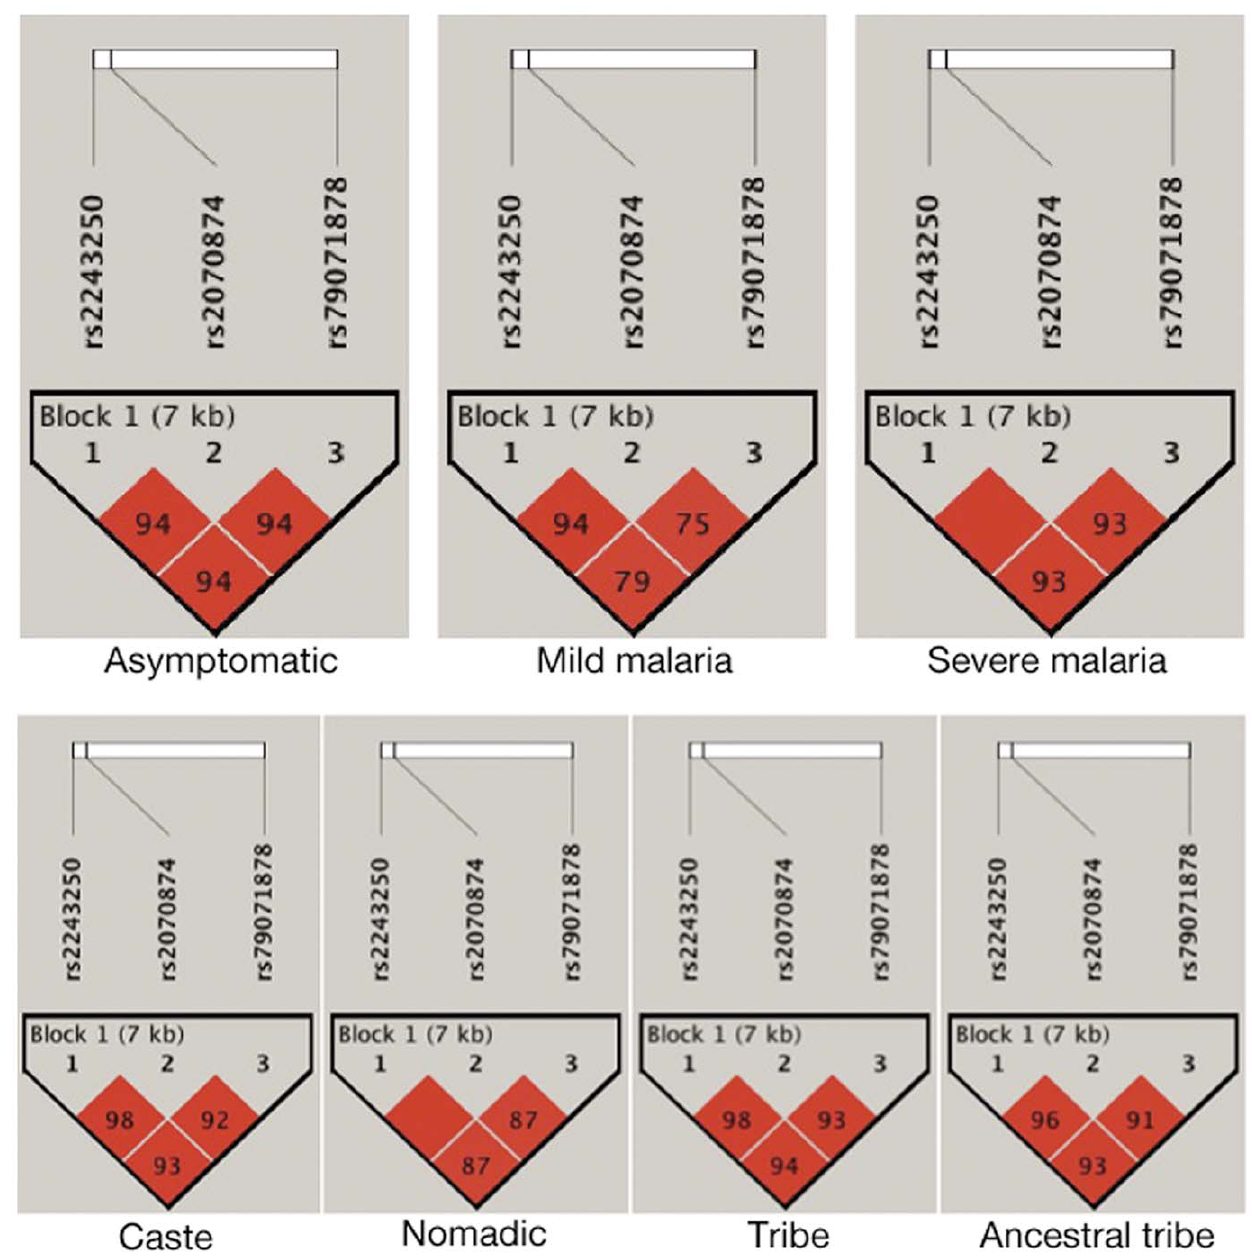
Figure 2. Linkage Disequilibrium (LD) of studied IL-4 loci (-590 C/T, -34 C/T and intron-3 VNTR) in malaria case control and Indian population groups. The three studied SNPs are in strong LD (r 2 . 0.75, malaria case control groups; r 2 . 0.87, population groups).